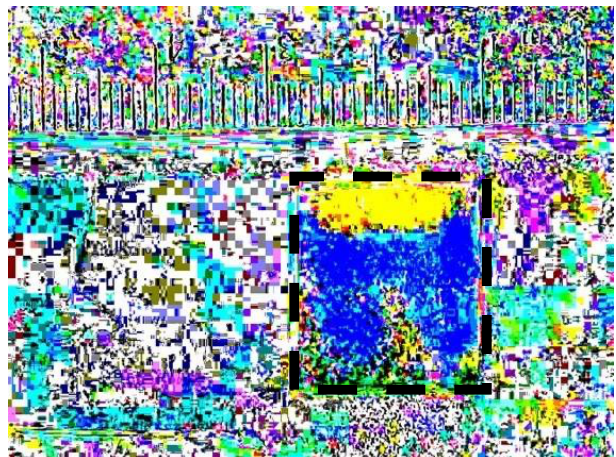
Figure 5. This figure displays an alternative to image subtraction, as seen Figure 4 panel (b). Here the first frame was inverted and was added to the final frame. This provides subtler details of color changes in the gauze pad (highlighted by dashed lines) by fluid movement. This allows for an